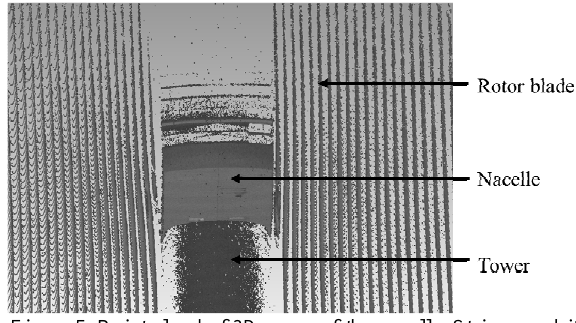
Figure 5. Point cloud of 3D scans of the nacelle. Stripes are hits on the rotating blades.